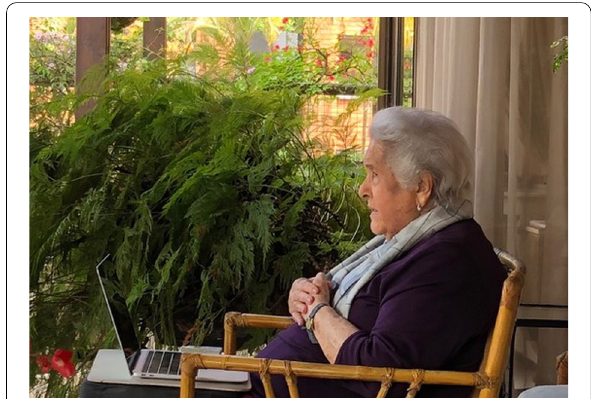
Fig. 19 Angela Restrepo